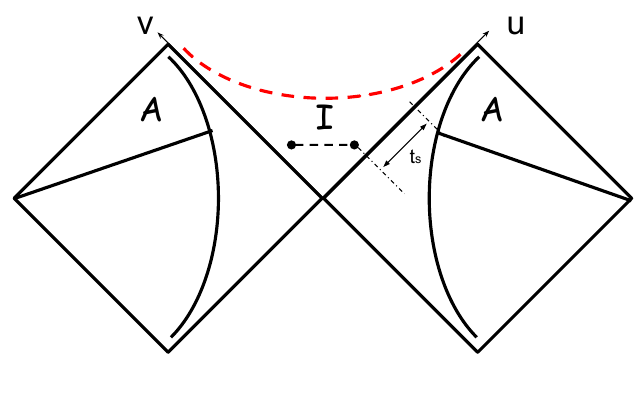
Figure 10. Illustration of the eternal black hole geometry and region A we are